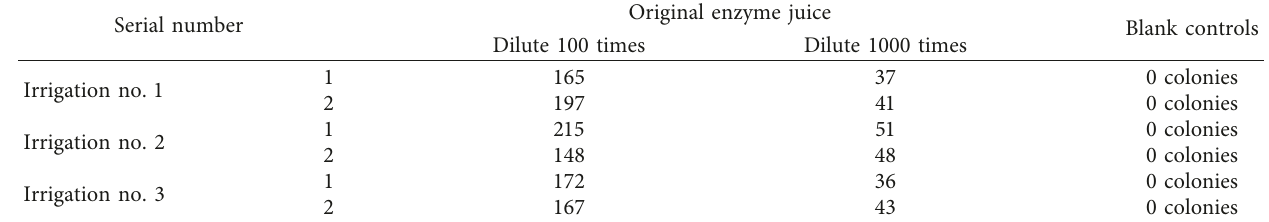
Table 13: Final test results for E. coli .